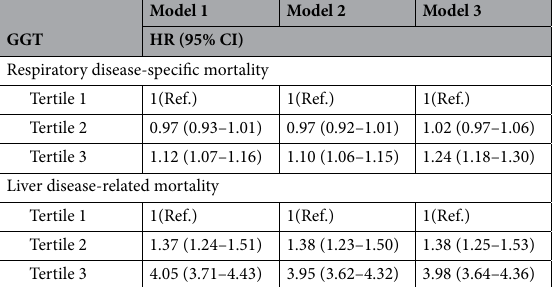
Table 2. Hazard ratios with 95% confidence interval for all-cause and disease-specific mortality by tertiles of gamma-glutamyl transferase. PY, person year; CVD, cardiovascular diseases, HR, hazard ratio; CI, confidence interval. Model 1 was adjusted for age and sex; Model 2 was adjusted for smoking status, alcohol consumption, physical activity, and low income in addition to covariates in model 1; Model 3 was adjusted for body mass index, alanine aminotransferase, diabetes mellitus, hypertension, dyslipidemia, and Charlson comorbidity index score in addition to covariates in model